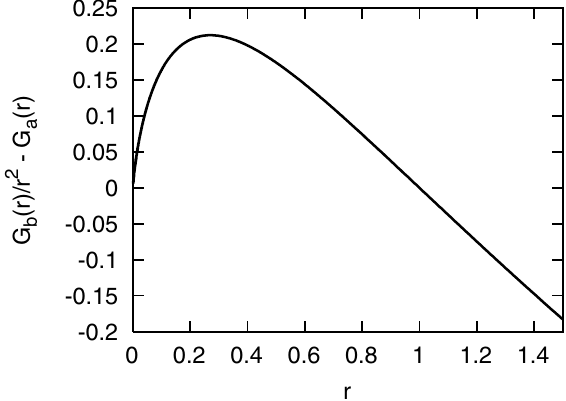
FIG. 7. Right-hand side of Eq. (32) as a function of r (cid:1) a=b